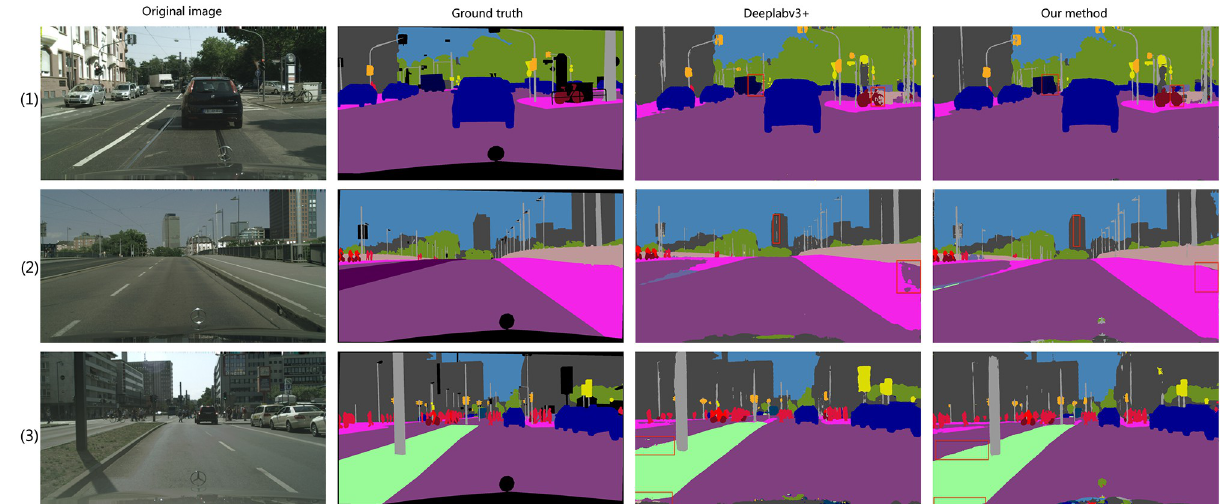
Fig 8. Comparison of DeepLabv3+ and MFEAFN visualization results on Cityscapes validation set. https://doi.org/10.1371/journal.pone.0274249.g008 scales or levels, we built the Frequency Selective Fusion Module (FSFM), which can enhance the adaptive fusion of these features by generating spatial and frequency correlation weight mappings for each feature map. Based on the DSPM and FSFM Module, we propose a multi- scale feature enhancement adaptive fusion network (MFEAFN) that effectively solves the prob- lems of local information loss and class confusion. Experimental results of the proposed algo- rithm on the PASCAL VOC 2012 and Cityscapes data sets show that MFEAFN has better segmentation performance than state-of-the-art methods. Table 5. Comparison with compared with state-of-the-Art on the Cityscapes dataset.